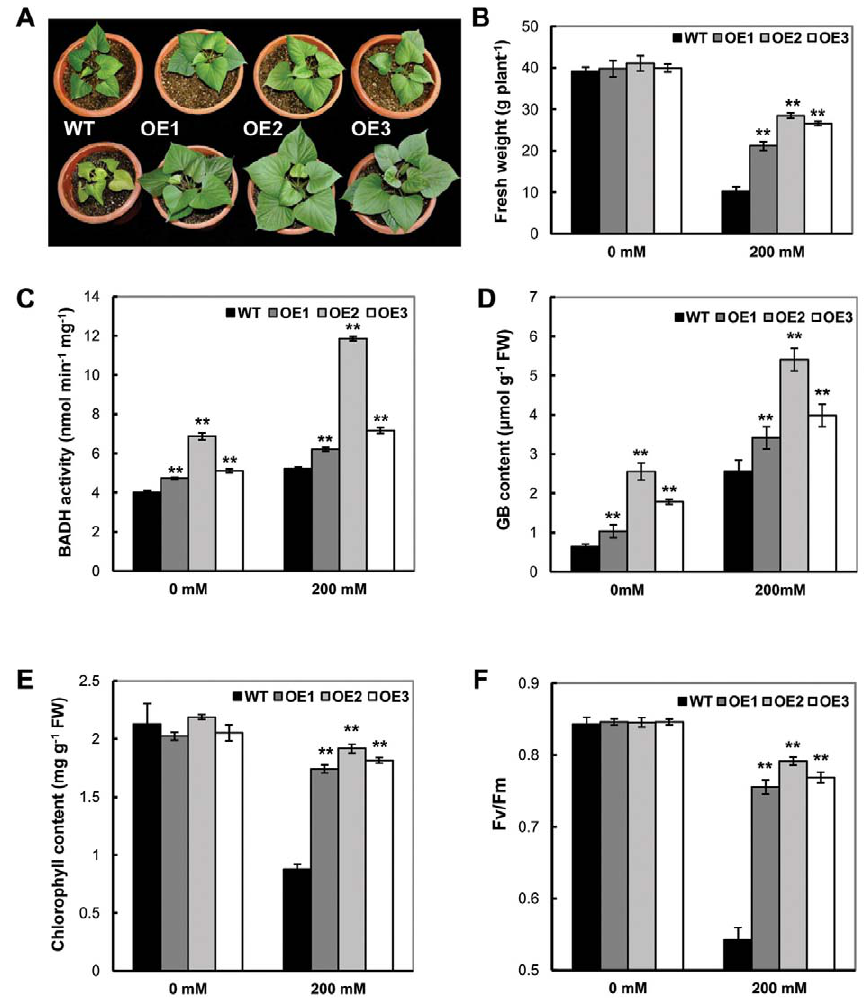
Figure 2. Phenotypic and physiological analyses of the SoBADH transgenic plants under 200 mM NaCl stress for 16 days. A, the phenotypic changes before (upper panel) and after NaCl treatment (lower panel); B, fresh weight of transgenic and WT plants after NaCl treatment; C, BADH activities in transgenic and WT plants before and after NaCl treatment; D, contents of GB in the leaves of transgenic and WT plants after NaCl treatment. E, chlorophyll content in the leaves of transgenic and WT plants after NaCl treatment; F, changes of maximum fluorescence ratios (Fv/Fm) in transgenic and WT plants upon NaCl stress. OE1–OE3, independent, SoBADH overexpressing transgenic lines; WT, wild-type plant. Values represent the mean 6 SD (n=9). Asterisks indicate a significant difference from that of WT at * P , 0.05 or ** P , 0.01 by t -test.